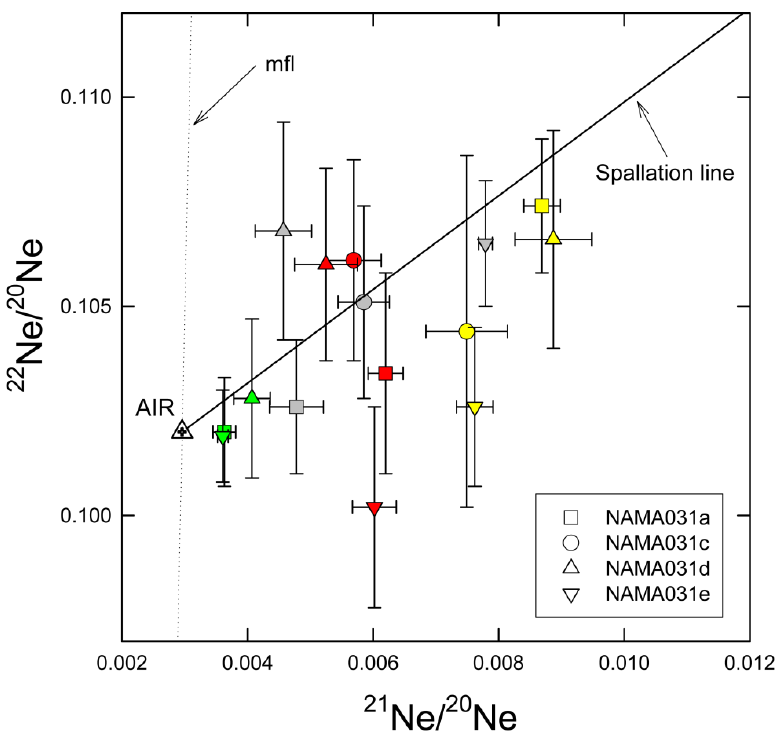
Figure 3. Neon three-isotope plot for stepwise heating and crushing data of NAMA031a, NAMA031c, NAMA031d and NAMA031e (grey—400 ◦ C, yellow—600 ◦ C, red—800 ◦ C, green—crushing extractions). The 1200 ◦ C data would plot out of scale far to the right (see Table 2). "Spallation line", i.e., mixing line of atmospheric and cosmogenic Ne, according to [56]. mfl: mass fractionation line. While the NAMA031a, NAMA031c and NAMA031d data are consistent with a two-component mixture of trapped Ne (as determined by the crusher extractions) and cosmogenic Ne, the 600 ◦ C and 800 ◦ C steps of NAMA031e may indicate the presence of some nucleogenic 21 Ne in addition. 2 sigma uncertainties are